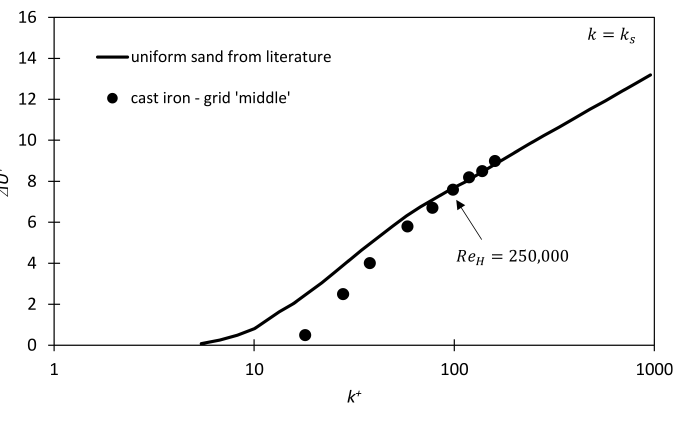
Figure 21. Roughness function ∆ u + = f ( k + s ) for the cast iron roughness. The roughness function for uniform sand from Nikuradse [54] is included in the figure.